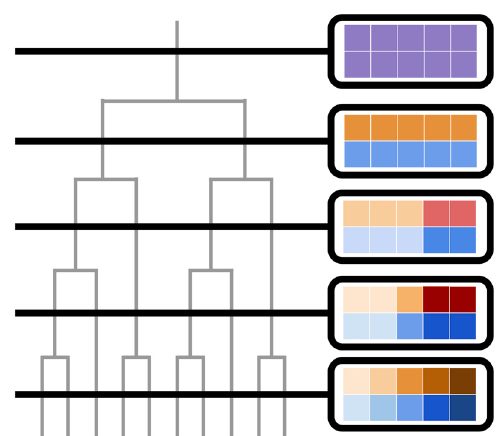
Figure 1. An explanation of a fibre plot. On the left, I show a phylogeny (in grey) with a series of slices cut through it (in black). To the right, I show views through those slices surrounded in black outlines: each of these slices forms the basis of a fibre plot. Within each slice, a square represents descendent tips, and colours of those squares represent the composition of clades within a particular time slice. Squares of the same colour form a “fibre” in the tree of life. A true fibre plot would be an animation of the transition between these slices, showing how the clades (fibres) that make up the tree split as diversification takes place. Alternate colouring schemes are possible for the fibres; the R implementation, by default, colours fibres according to clade age, and allows for different colouring schemes within a plot to highlight taxa of